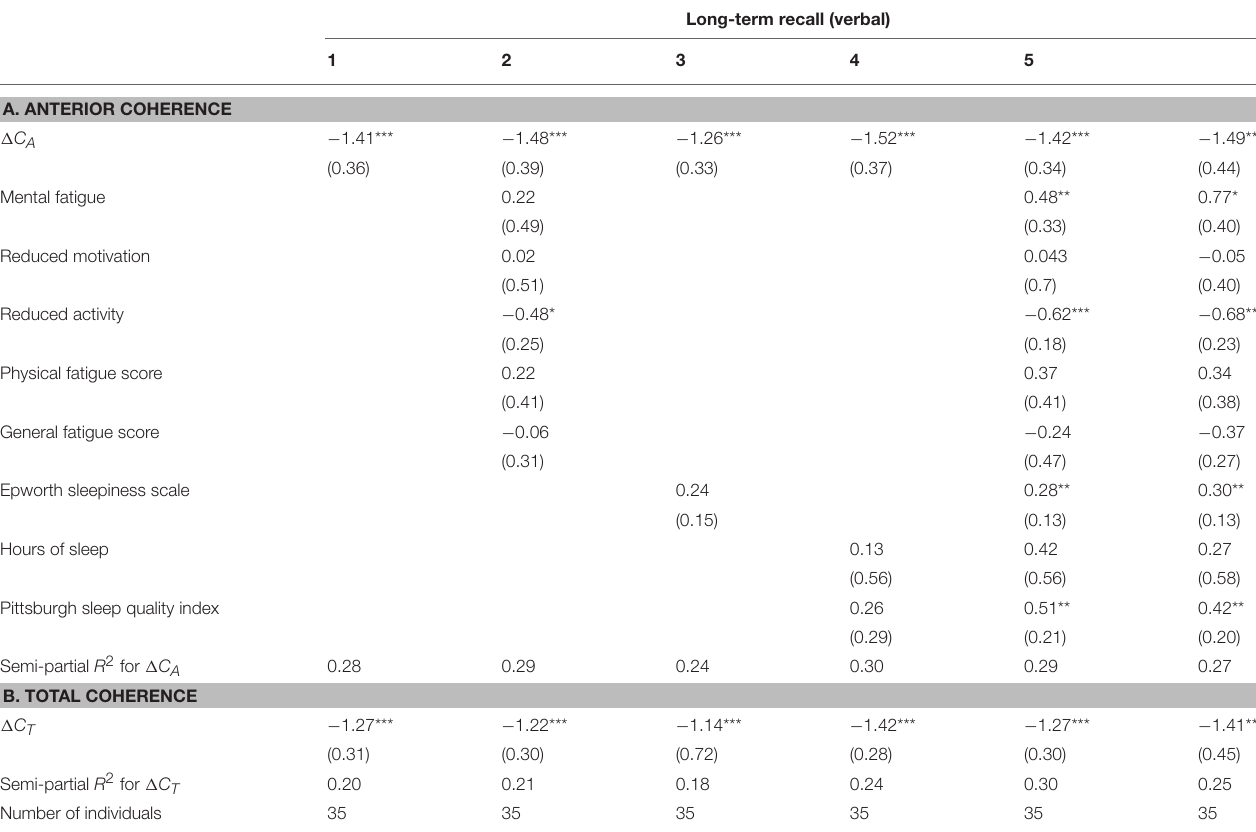
TABLE 8 | Linear regression of long-term memory on 1 C —when controlling for sleep habits and fatigue.